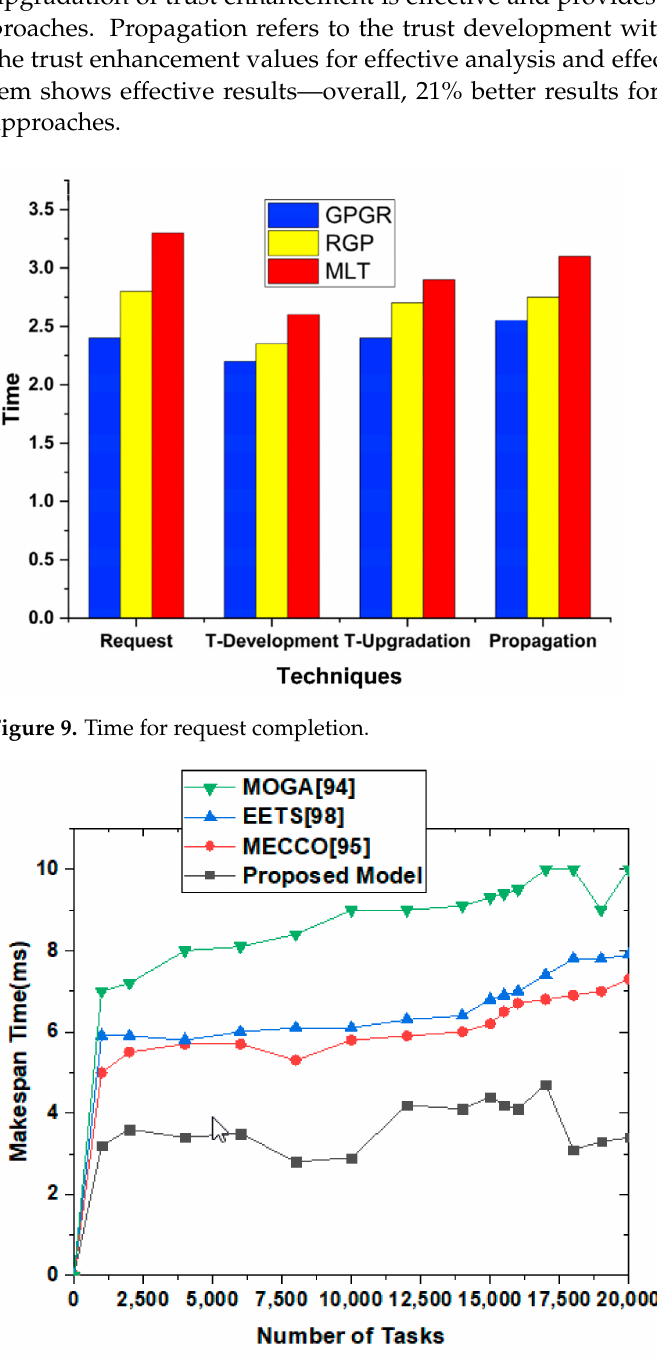
Figure 10. Makespan time consumption after increasing the number of tasks to